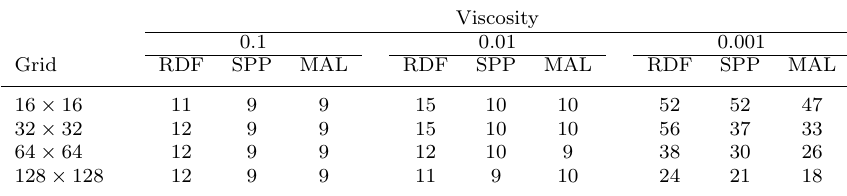
Table 3. Number of GMRES(20) iterations with the RDF, MAL and SPP precondi- tioners for steady Oseen problems (Q2-Q1 FEM uniform grids), the parameters τ , α , γ are respectively obtained by Fourier analysis.